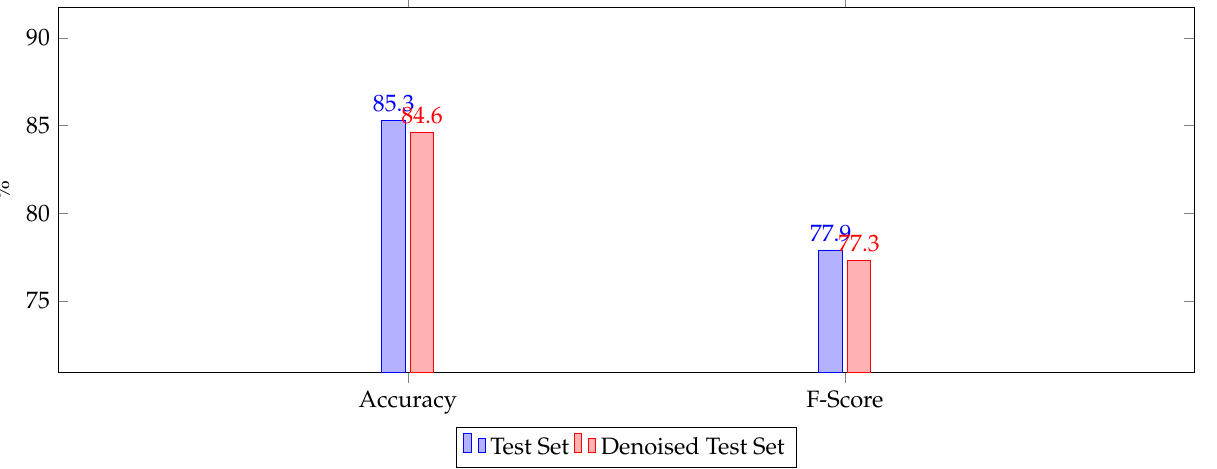
Figure 15. Accuracy and F-1 score obtained over the combined test set and the combined denoised test